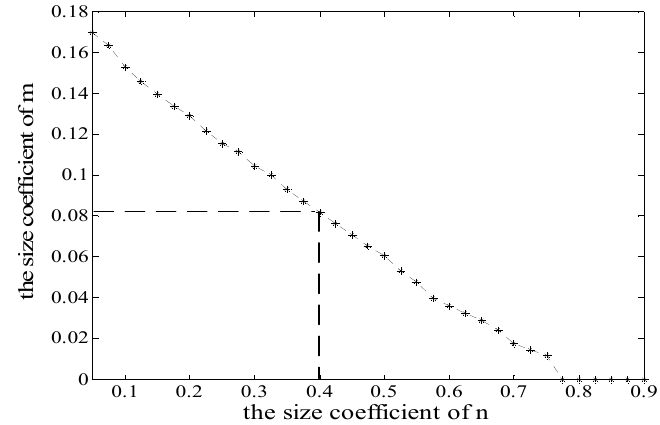
Figure 18. The stable region for size coefficients λ